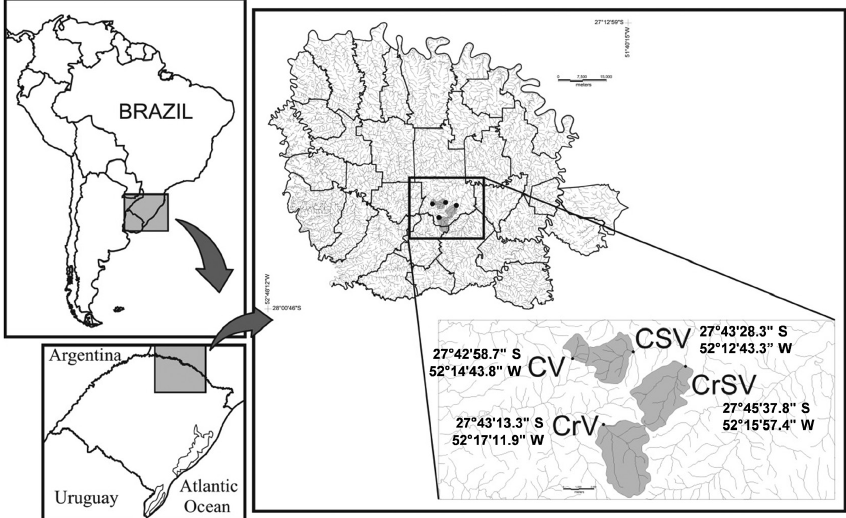
Figure 1. Map of the sampling sites. CV (riparian vegetation) and CSV (agriculture land use) at Campo River sub- Basin. CrV (riparian vegetation) and CrSV (agriculture land use) at Cravo River sub-Basin. Based on the protocol described by Callisto et al. (2002) CV and CrV are natural environments (80 and 85 points, respectively); CS are altered and CrSV are impacted environments (47 and 40 points,